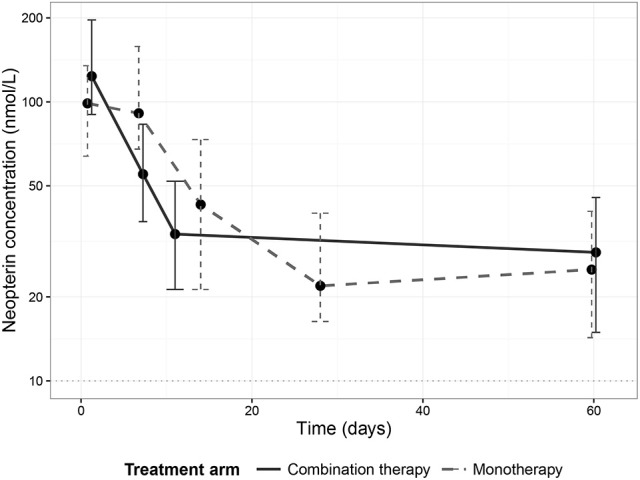
Neopterin dynamics per treatment arm. Dynamics of median neopterin concentrations in visceral leishmaniasis patients undergoing a combination therapy of L-AMB and miltefosine (solid line) or miltefosine monotherapy (dashed line). Error bars represent the inter-quartile range (IQR).